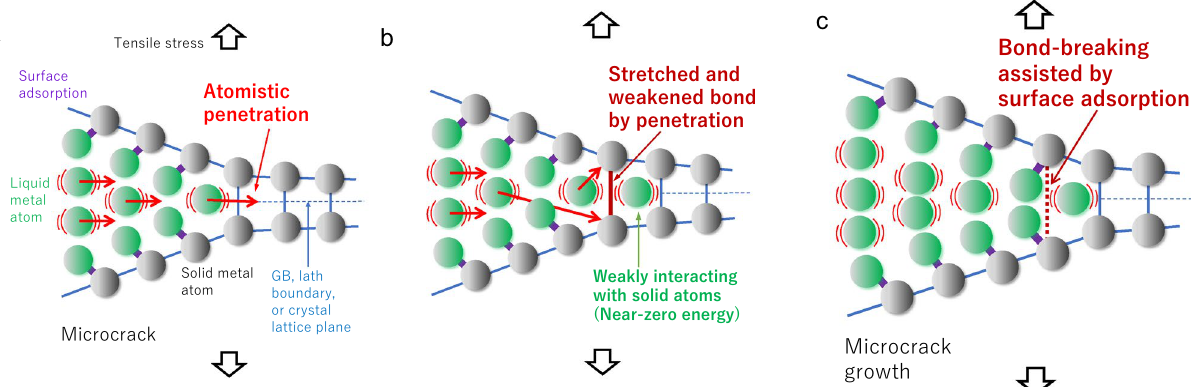
Figure 2. A proposed atomistic process of bond-breaking at a microcrack tip. ( a ) Atomistic penetration of liquid metal atom into GB, lath boundary, or lattice plane of solid metal at a microcrack tip under tensile stress. ( b ) The atomistic penetration of liquid metal with weak interaction (near-zero energy) stretches and weakens the solid metal bonding. ( c ) The subsequent surface adsorption of liquid metal atoms achieves the bond- breaking of solid metals. The process of ( a – c ) repeats, and the microcrack grows when the weak interaction criterion is